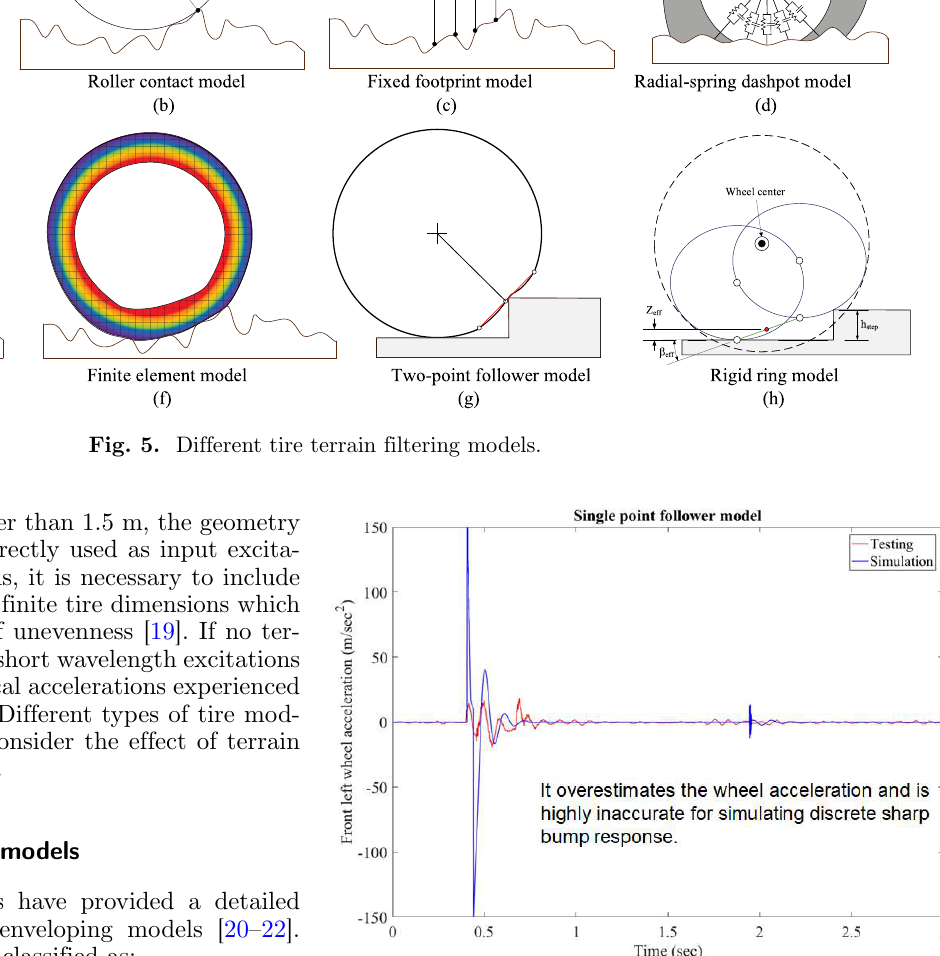
Fig. 6. Single point follower model fitting against